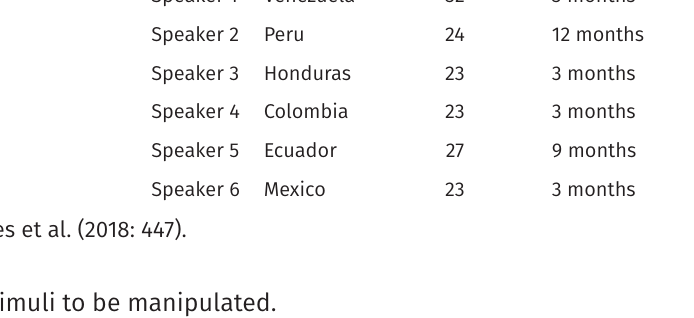
Table 2: Stimuli to be